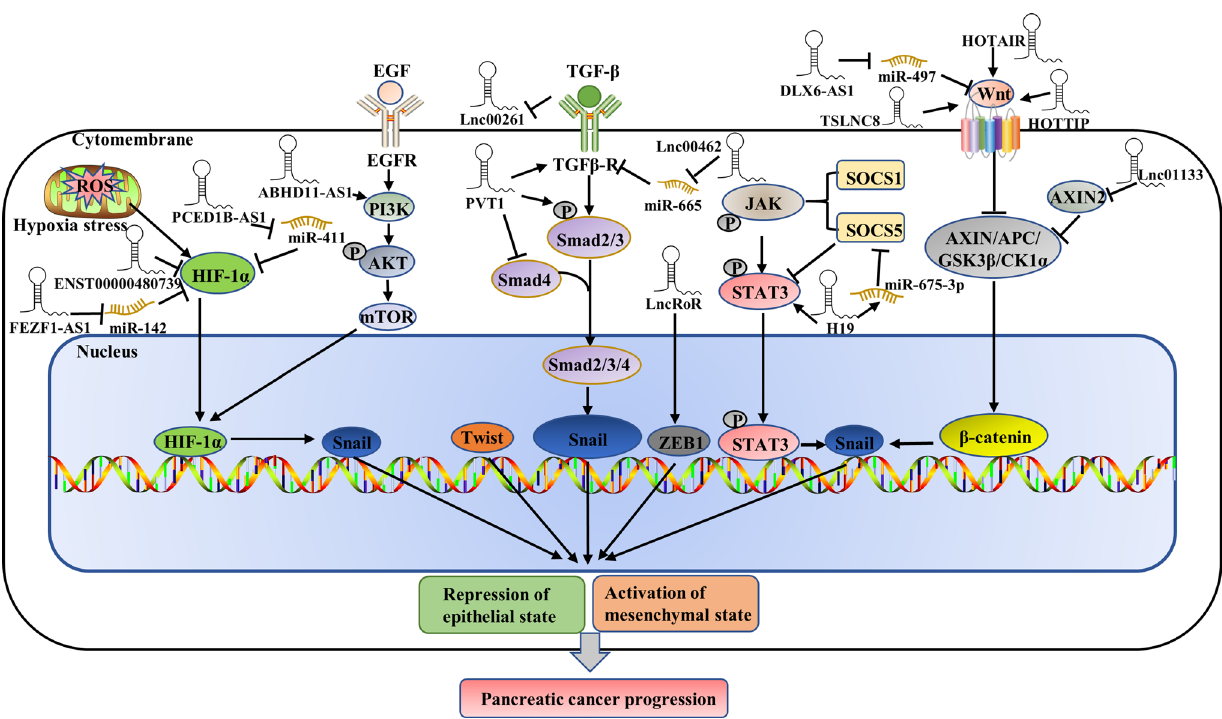
Fig. 2 The progression of epithelial-mesenchymal transition is regulated by lncRNAs that are involved in multiple complex signaling path- ways, such as the TGFβ/SMAD2/3, Wnt/β-catenin, mTOR, HIF-1α and JAK/STAT3